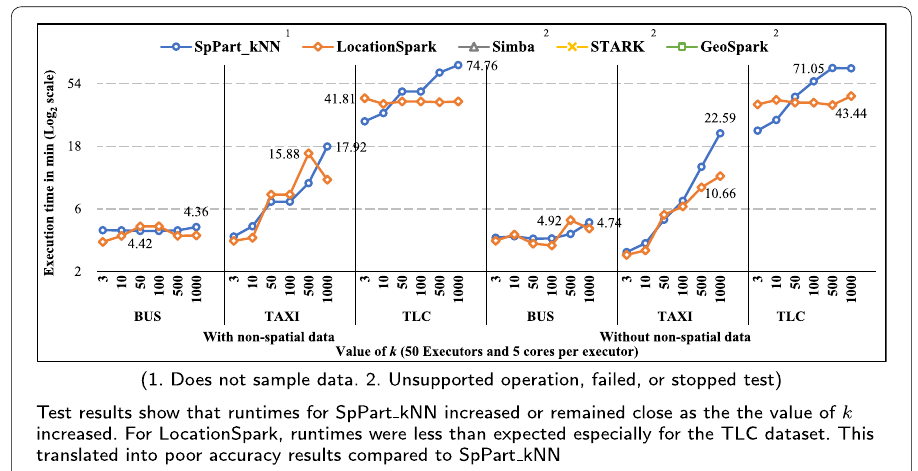
Fig. 15 Varying the value of k with and without non-spatial